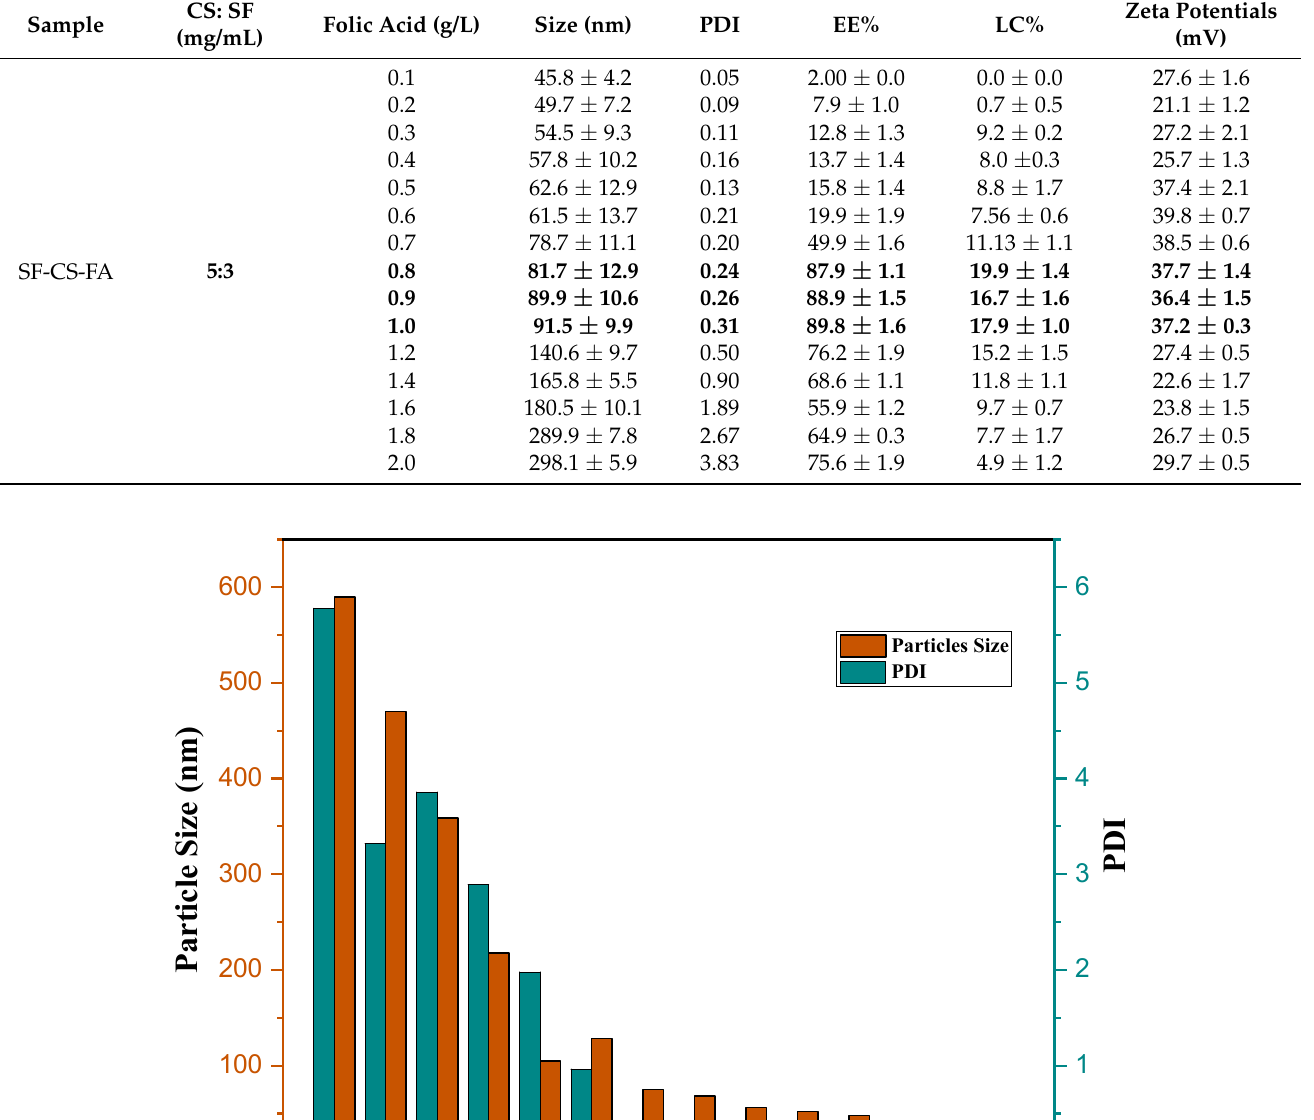
Table 1. The effect of size, poly dispersity index, encapsulation efficiency (%) and loading content (%), and zeta potential on chitosan: Sorafenib ratios. Optimal parameters are shown in bold.